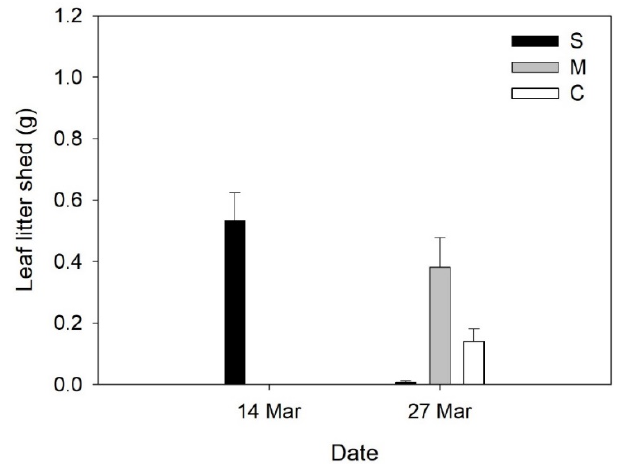
Figure 6. Leaf litter (mean values +SE) shed by Cistus salviifolius on different dates after the start of water deficit treatments on 3 March 2017 for plants under severe water deficit (S), moderate water deficit (M) and control (C).